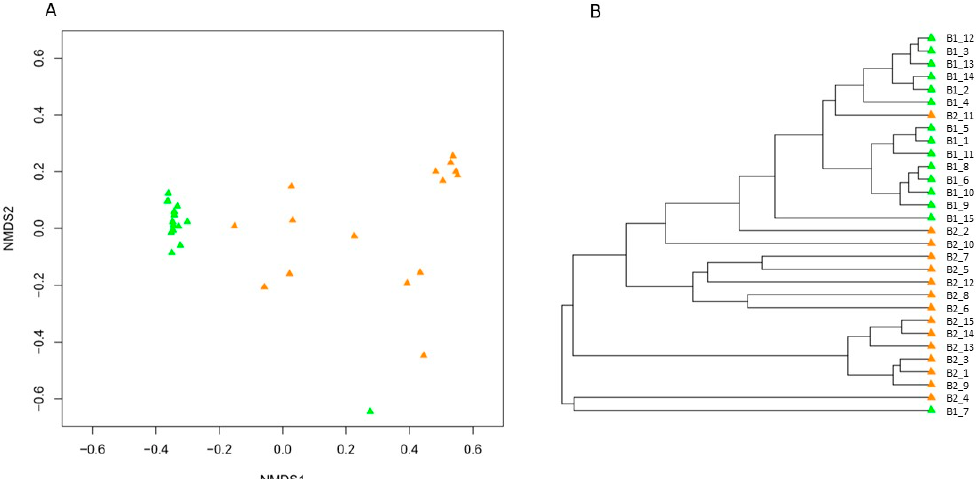
Figure 2. ( A ) Non-metric multidimensional scaling (NMDS) ordination (stress value = 0.09) based on Bray–Curtis similarities depicting the gut (midgut and ileum) bacterial community composition of indoor-reared bumblebee queens ( Bombus terrestris ) before (green; n = 15) and after hibernation (orange; n = 15). The distance between different points on the plot reflects the similarity level in bacterial community composition: the more similar the bacterial communities, the smaller the distance between the points. ( B ) UPGMA (Unweighted pair group method with arithmetic mean) dendrogram visualization of the clustering analysis.